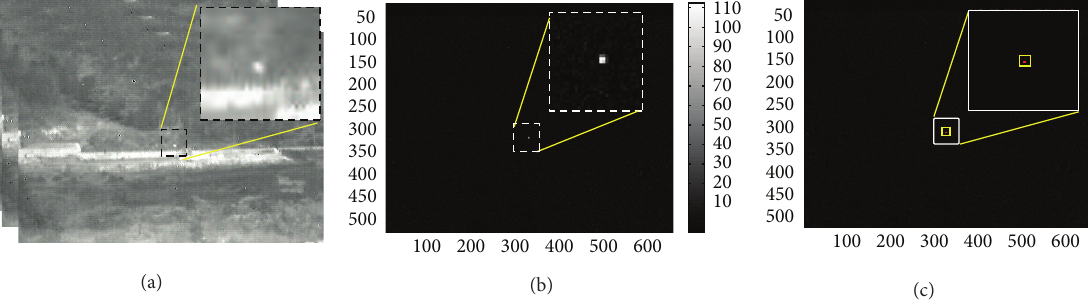
Figure 17: Supersonic target detection procedures with results: (a) input sequence, (b) TCF results, and (c) hysteresis threshold detection